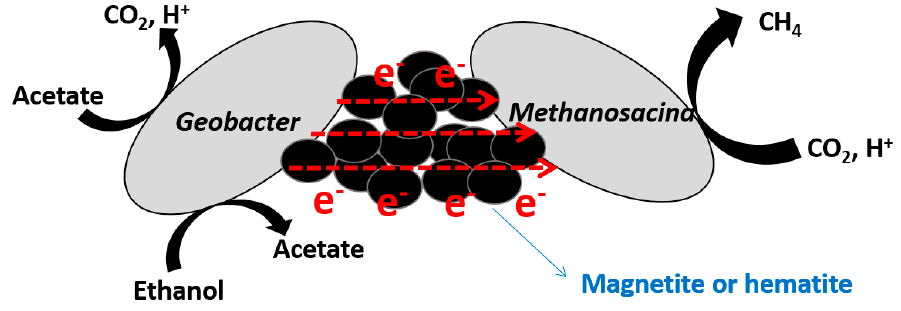
Figure 4. Schematic of suggested mechanisms under hematite- and magnetite-supplemented conditions.